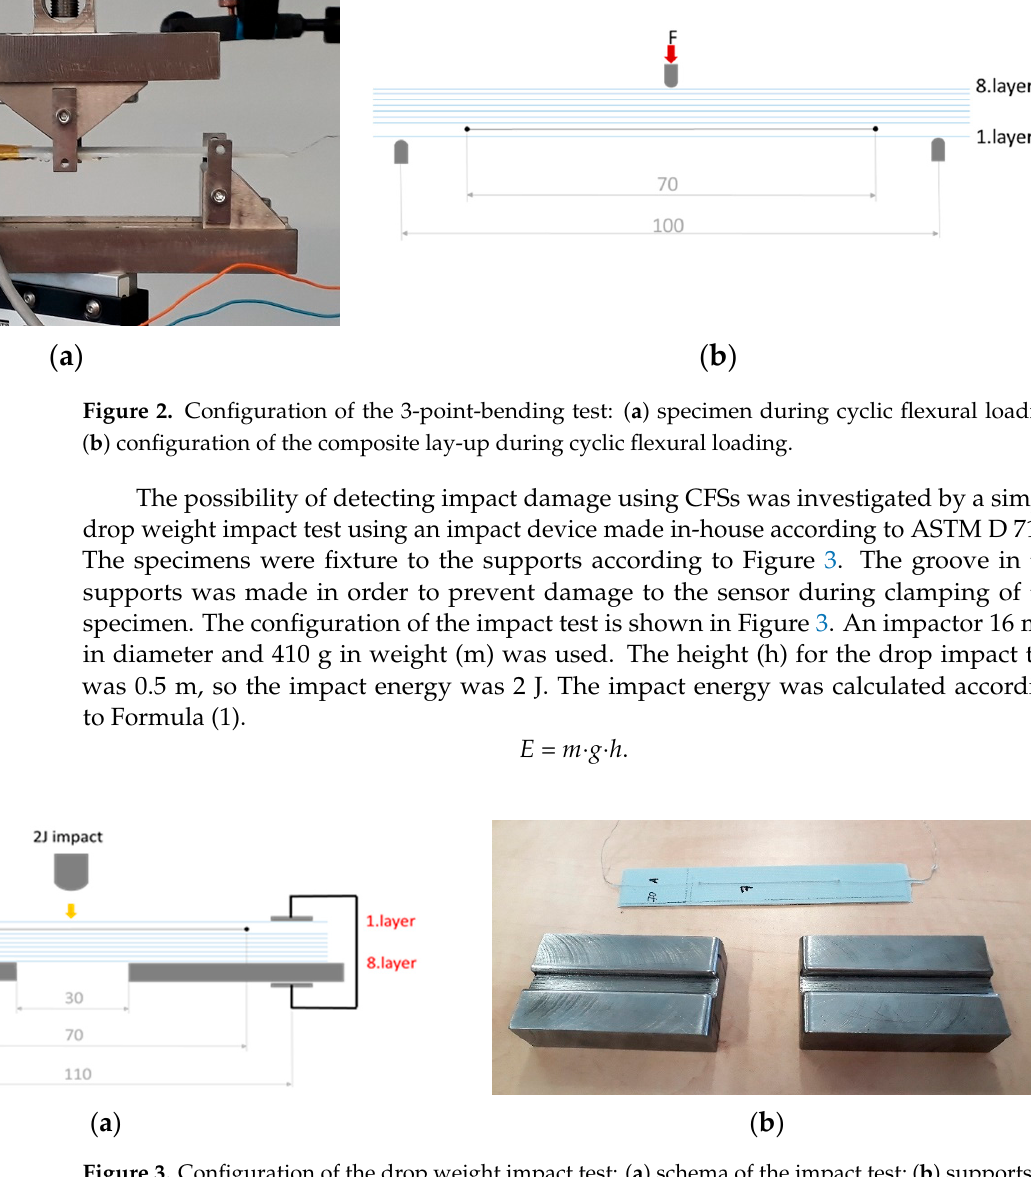
Figure 2. Configuration of the 3-point-bending test: ( a ) specimen during cyclic flexural loading; ( b ) configuration of the composite lay-up during cyclic flexural loading.